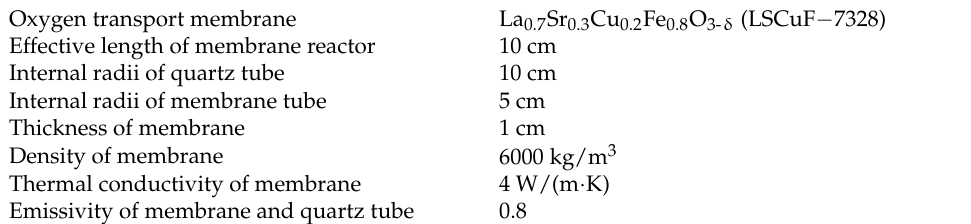
Table 1. Composition, dimensions, and physical parameters of membrane reactor.